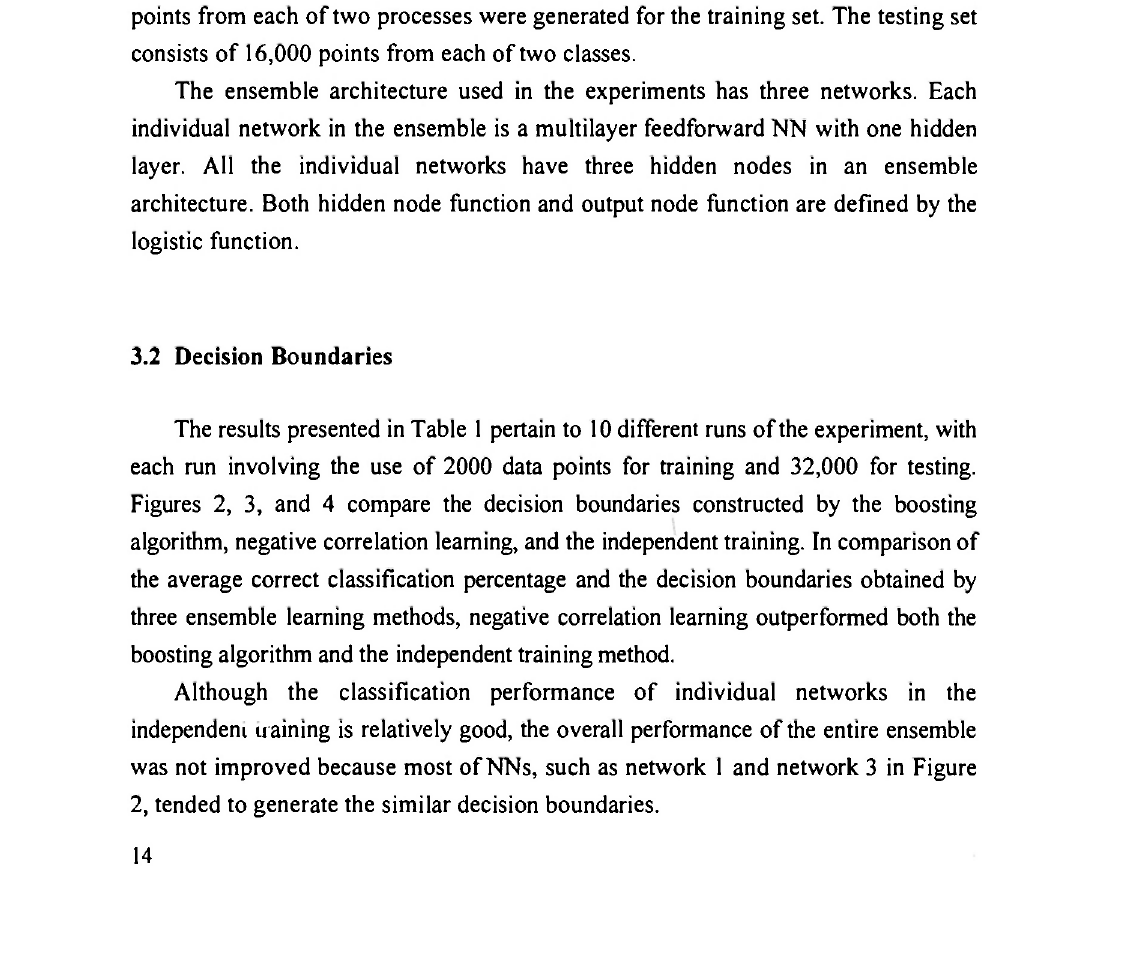
classifications are assumed to be zero. On this basis, the (optimum) Bayes classifier achieves a probability of correct classification p c = 81.51 percent. The boundary of the Bayes classifier consists of a circle of center [-2/3, 0] T and radius r = 2.34. 1000 points from each of two processes were generated for the training set. The testing set consists of 16,000 points from each of two